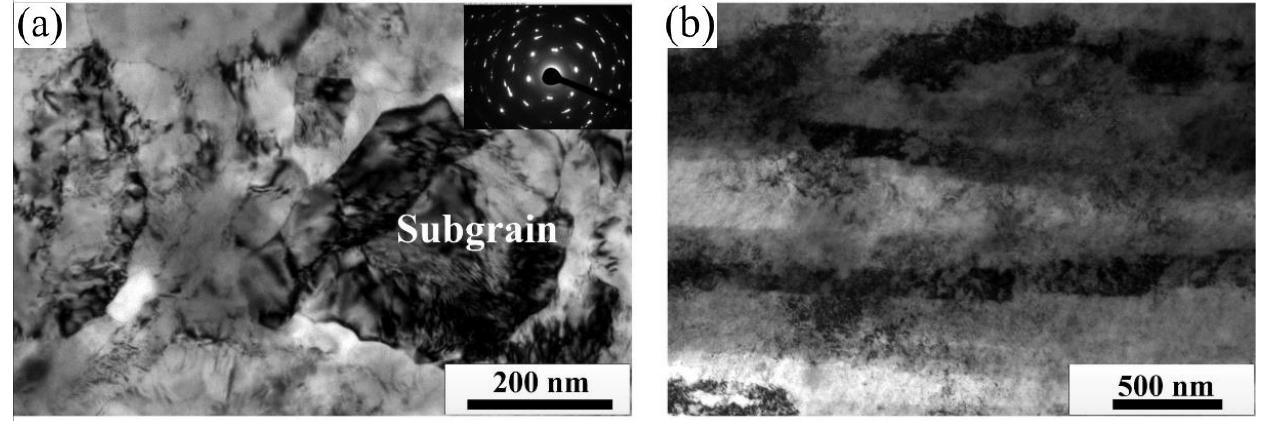
Figure 12. Grain structure of cold rolled strip (ε = 98%), ( a ) EG strip and ( b ) CG strip. The two alloys were analyzed by XRD, and the microstrain and dislocation density were statistically analyzed by Jade5.0 software. The microstrain [20] was estimated by Formula (1). Formula